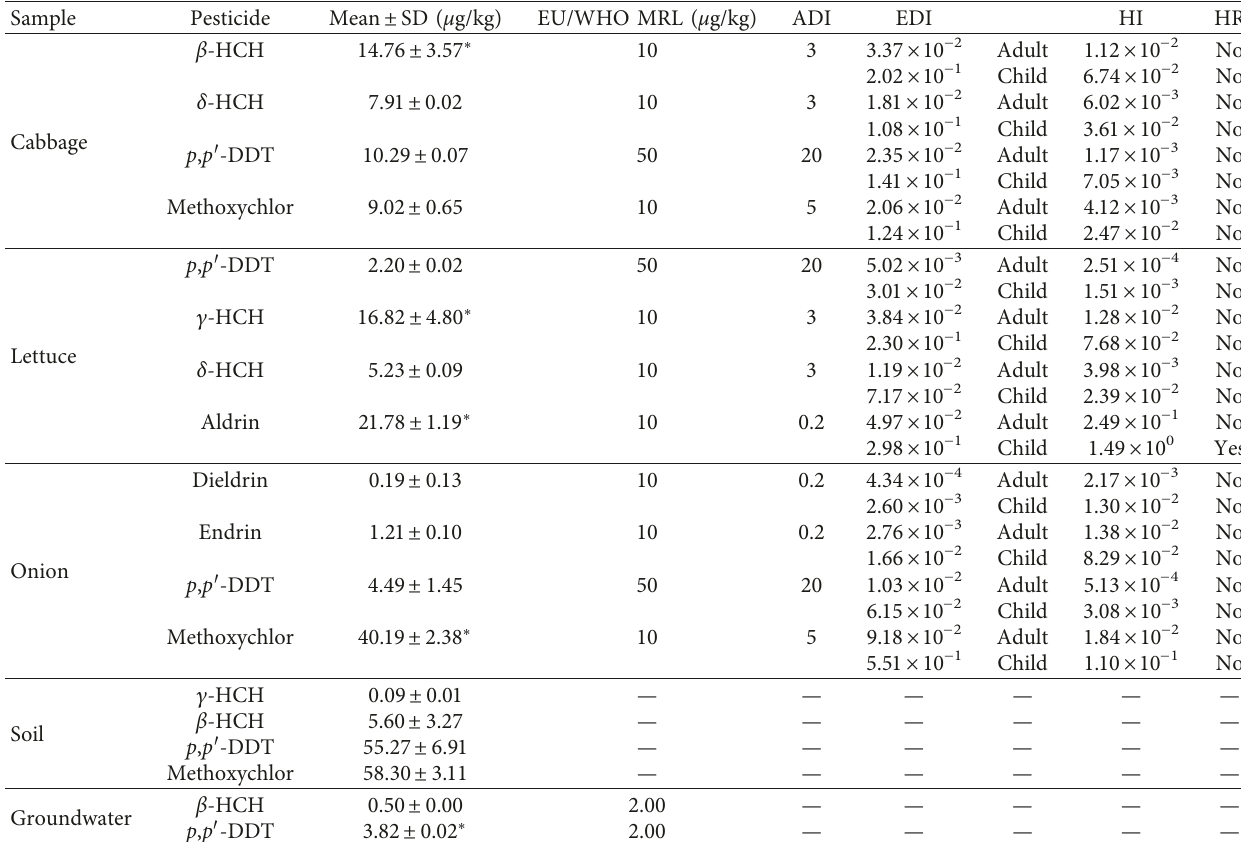
Table 6: Concentration, EDI, and health risk estimation for OCP residues detected in vegetables from Anglican Hostel. Sample Pesticide